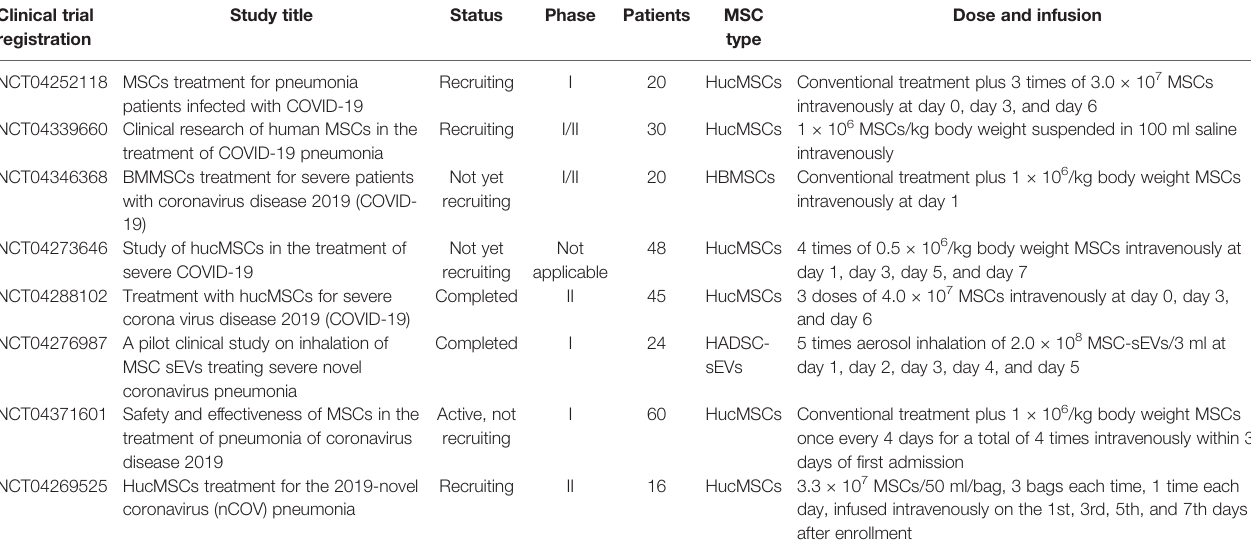
TABLE 2 | Ongoing or recently completed Chinese clinical trials with MSCs/MSC-sEVs in